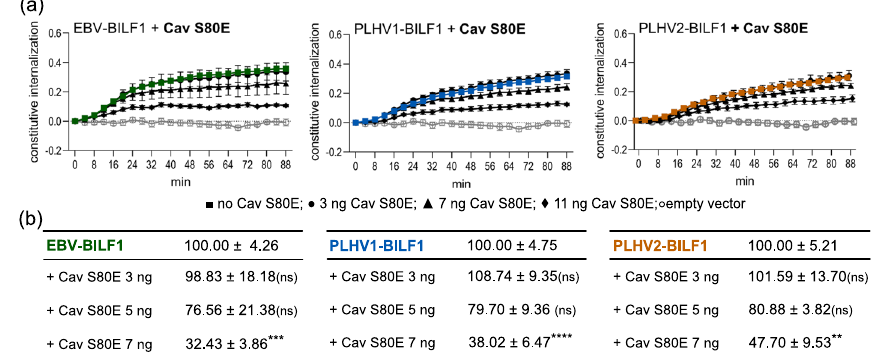
Fig. 4 Internalization of BILF1 receptors depends on caveolin‑1 function. a SNAP-EBV-BILF1 (green), SNAP-PLHV1-BILF1 (blue), SNAP-PLHV2-BILF1 (orange), and empty vector (gray) were expressed in HEK-293A cells together with different concentrations of Cav S80E DNM (black circle 3 ng; black up-pointing triangle 5 ng; black diamond 7 ng). Labeling with the donor SnapLumi4-Tb was performed at 4 °C to prevent any internalization prior to the measurement. Internalization was measured every 4 min for 88 min at 37 °C. The graph curves represent the ratios between donors and acceptors. b The area under the curve (AUC) was calculated for each curve and was normalized to each BILF1 receptor’s AUC in the absence of Cav S80E (100%) and empty vector (0%). Statistical differences were determined by Dunnett’s multiple comparison two-way ANOVA test. ** P < 0.01, *** P < 0.001, **** P < 0.0001